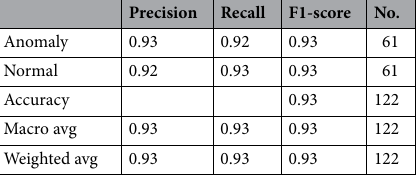
Precision Recall F1-score No.